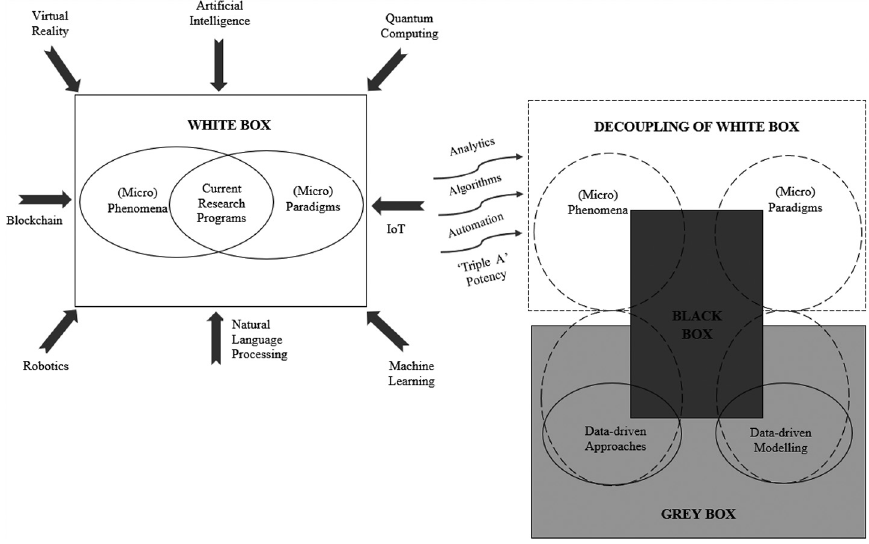
Figure 1. The box framework: white box, black